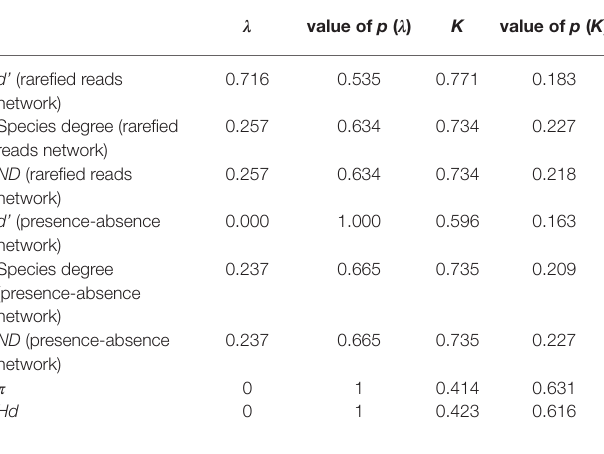
TABLE 4 | Summary of phylogenetic signal